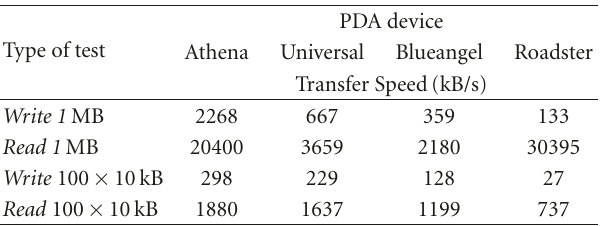
Table 2: Data transfer tests—SPB Benchmark software—Internal flash memory of PDA